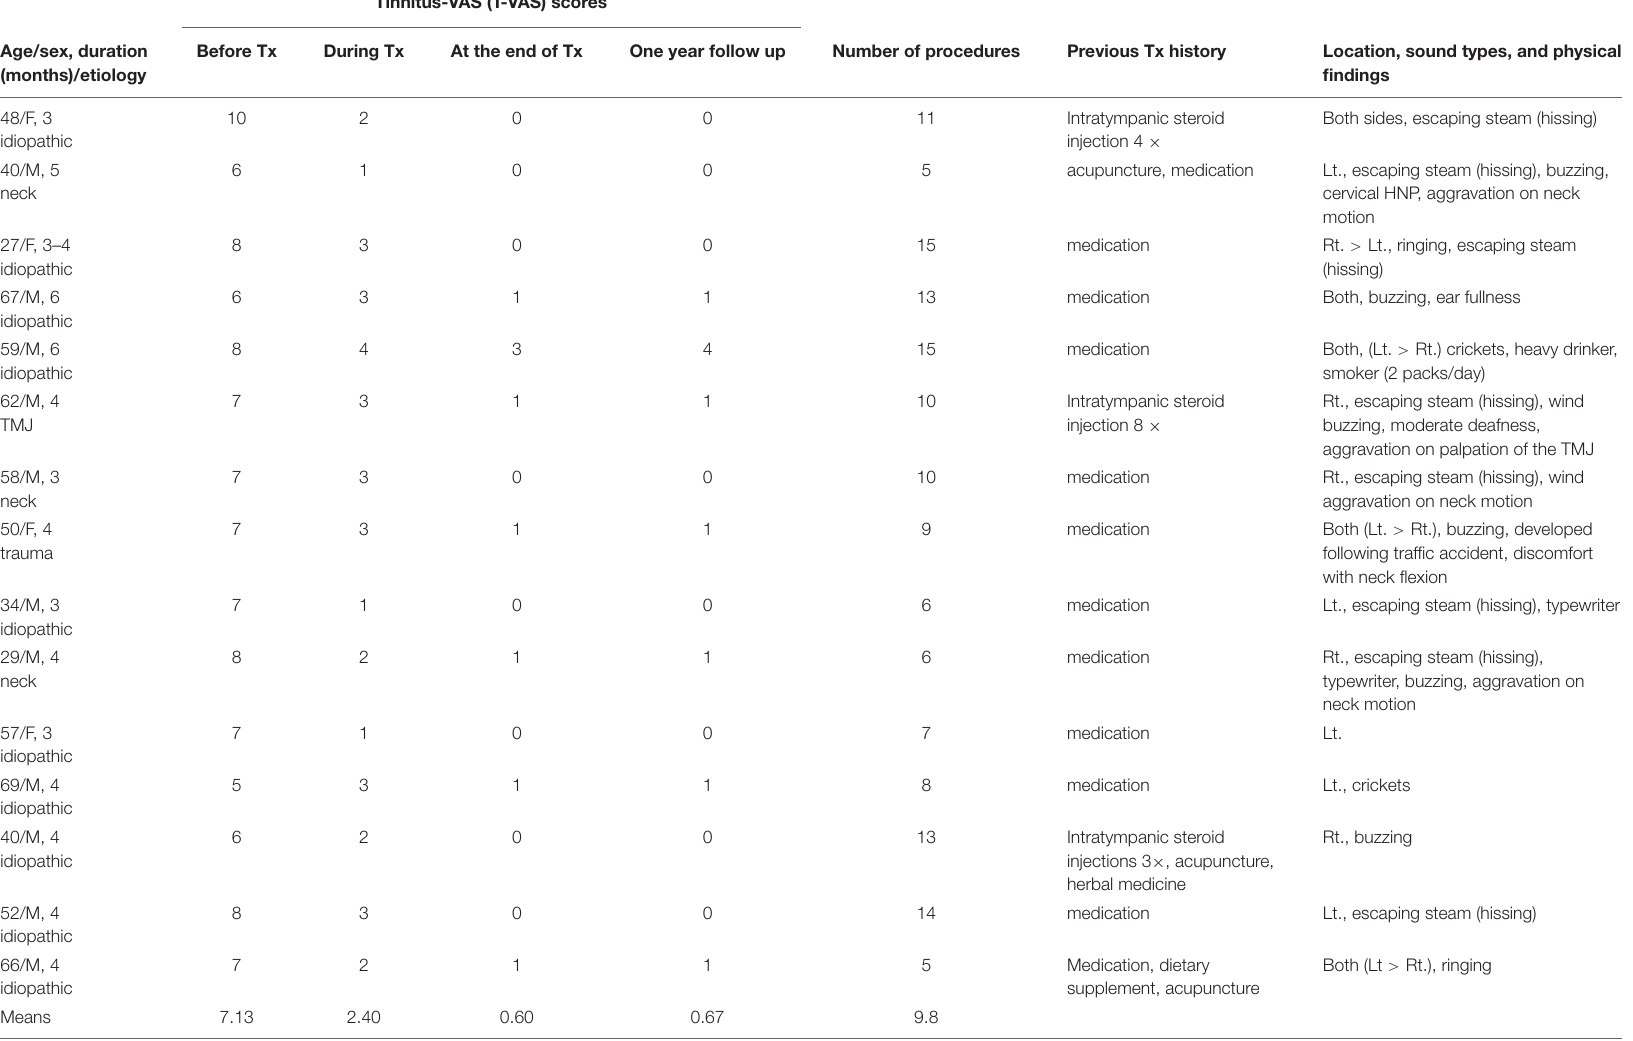
TABLE 1 | Patients with subacute tinnitus: demographic data, visual analog scale (VAS) scores, and clinical findings. Tinnitus-VAS (T-VAS)